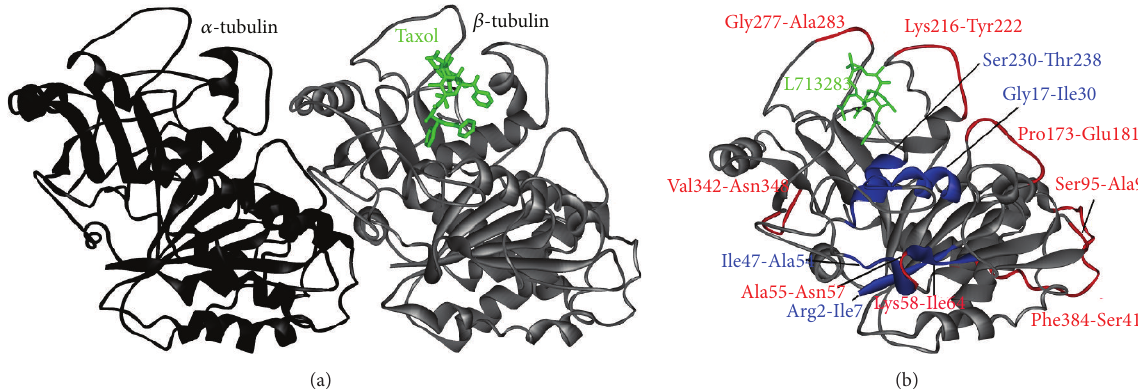
Figure 6: Fluctuation region analysis of 𝛽 -tubulin. (a) The solid ribbon representation of 𝛼𝛽 -tubulin system (PDB code: 1JFF). (b) The high (color in red) and low (text with rectangular border, color in blue) fluctuation of 𝛽 -tubulin.